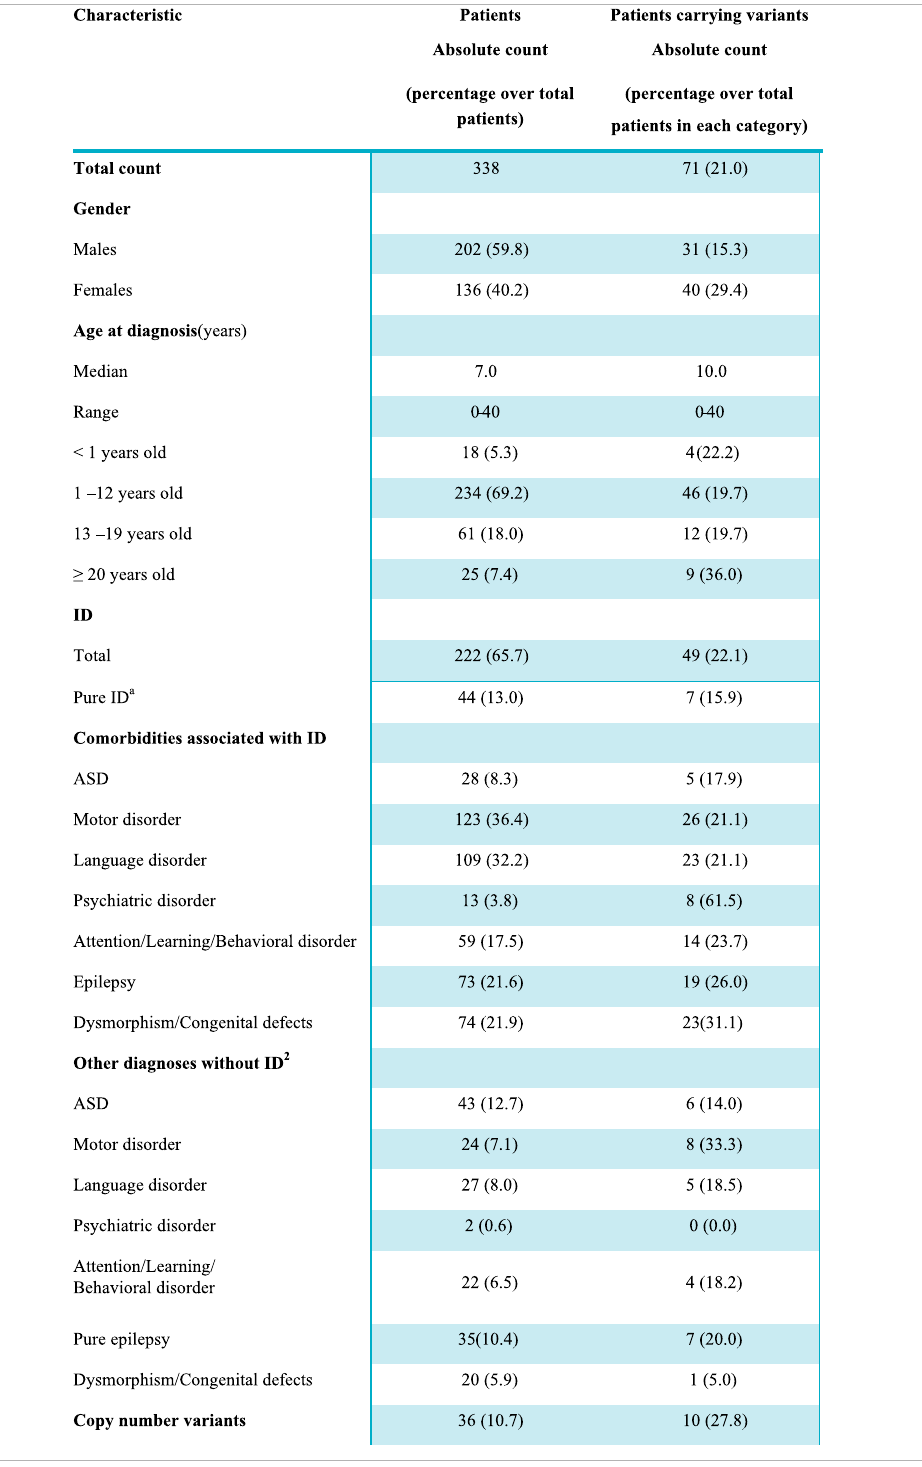
TABLE 1 | Clinical characteristics of the 338 subjects and diagnostic